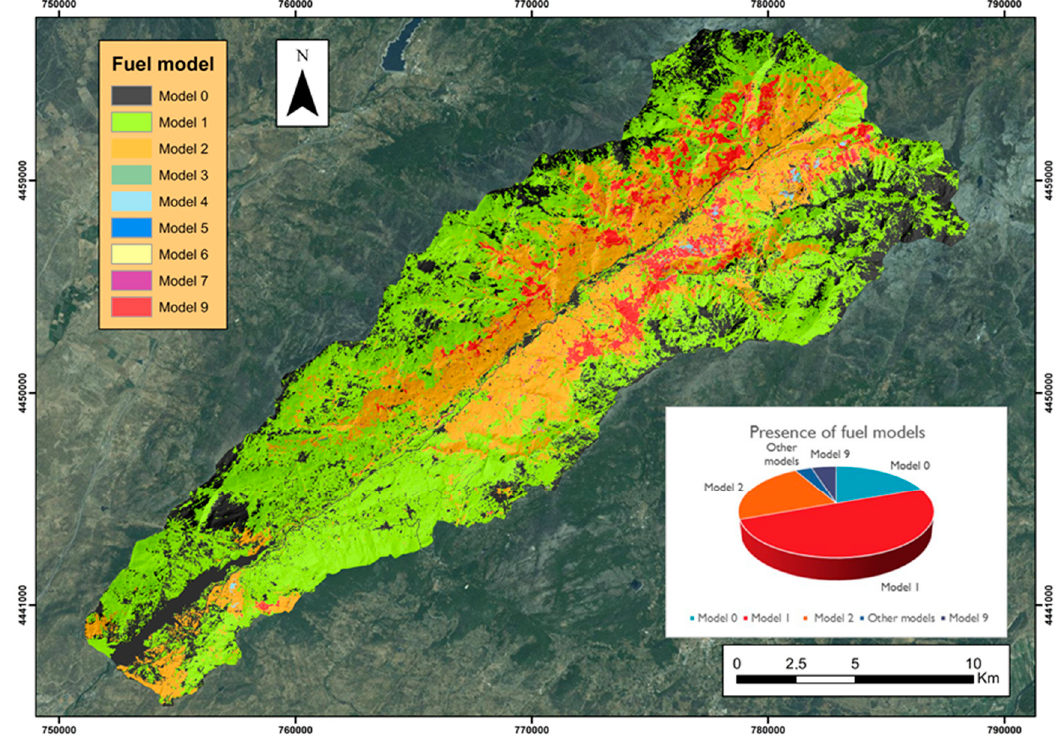
Figure11. Fuel-models mapping. Figure 11. Fuel-models